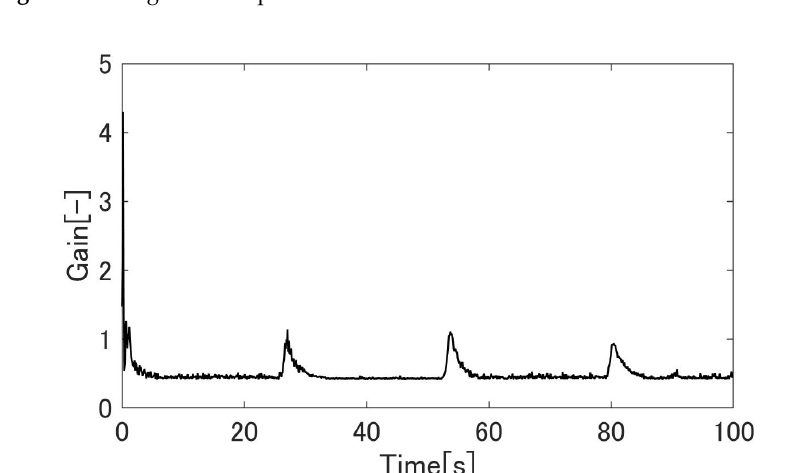
Figure 25. The gain of the previous method.